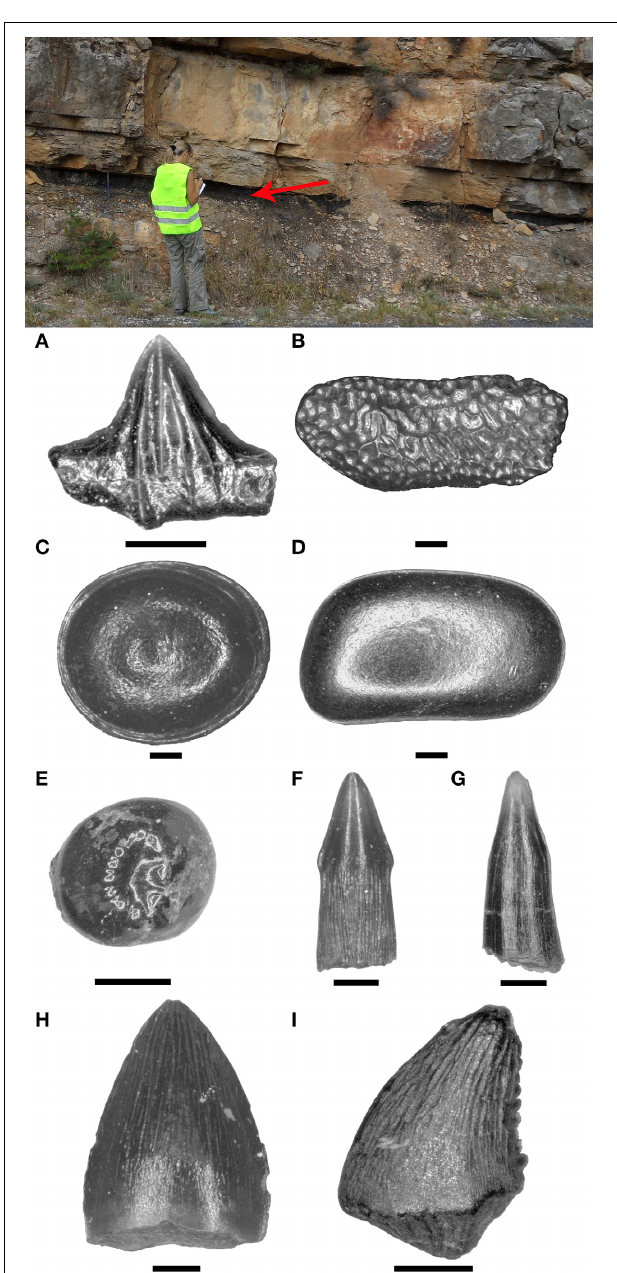
FIGURE 1 | Coal exposure (arrow) at “Les Gardies” (Nant, Aveyron) and representative sample of the teeth found at this site (all housed in the Museum für Naturkunde, Berlin, Germany). (A) Hybodus sp., labial view, (B) Asteracanthus sp., apical view; (C) Lepidotes sp., apical view; (D) Macromesodon sp., apical view; (E) Pycnodontidae indet. (cf. Coelodus sp.), apical view; (F) Caturus sp., lingual view (G) Aspidorhynchus sp., labial view; (H) Atoposauridae indet., labial view; (I) Theropoda indet., lingual view. Scale bars equal 500 µ m.